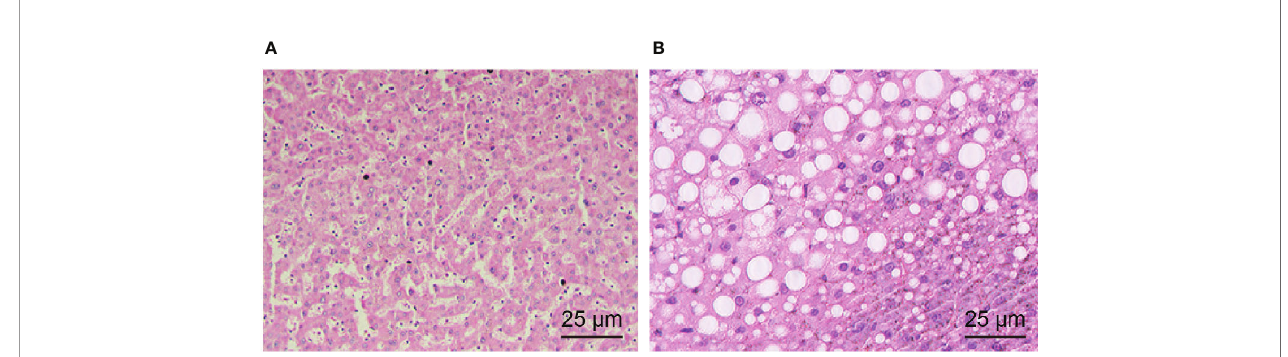
FIGURE 1 | Morphological observations of liver tissues of normal rats and AH rats. (A) The liver tissues of normal rats colored by HE staining (× 400). (B) The liver tissue of AH rats colored by HE staining (× 400).